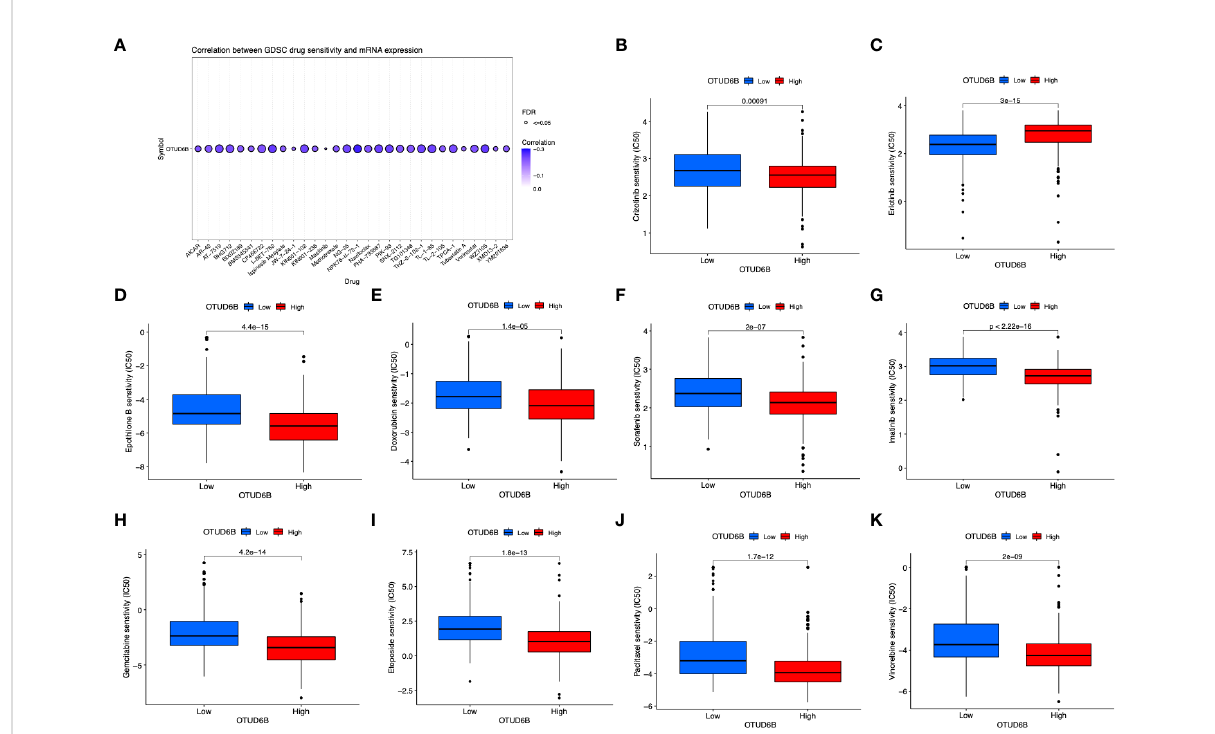
FIGURE 11 Relationship of OTUD6B expression with drug response. (A) The relationship between OTUD6B expression and GDSC drug sensitivity. Estimated IC50 indicating the ef fi ciency of chemotherapy to ERGs in low- and high-risk patients of pazopanib (B) , crizotinib (C) , erlotinib (D) , epothilone B (E) , doxorubicin (F) , sorafenib (G) , imatinib (H) , gemcitabine (I) etoposide (J) , paclitaxel (K) ,